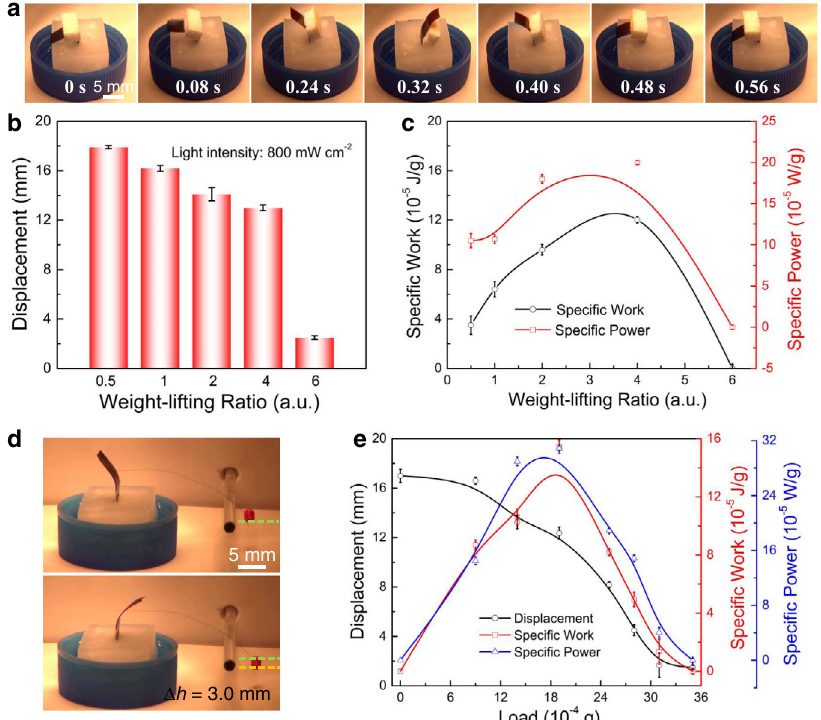
Fig.5|Workcapacityofthelightengine.a Photographsofoscillating fi lmloaded with an object. b Displacement with different weight-lift ratios. c Work and power asafunctionoftheweight-liftratiouponinfraredirradiation. d Photographsof fi lm